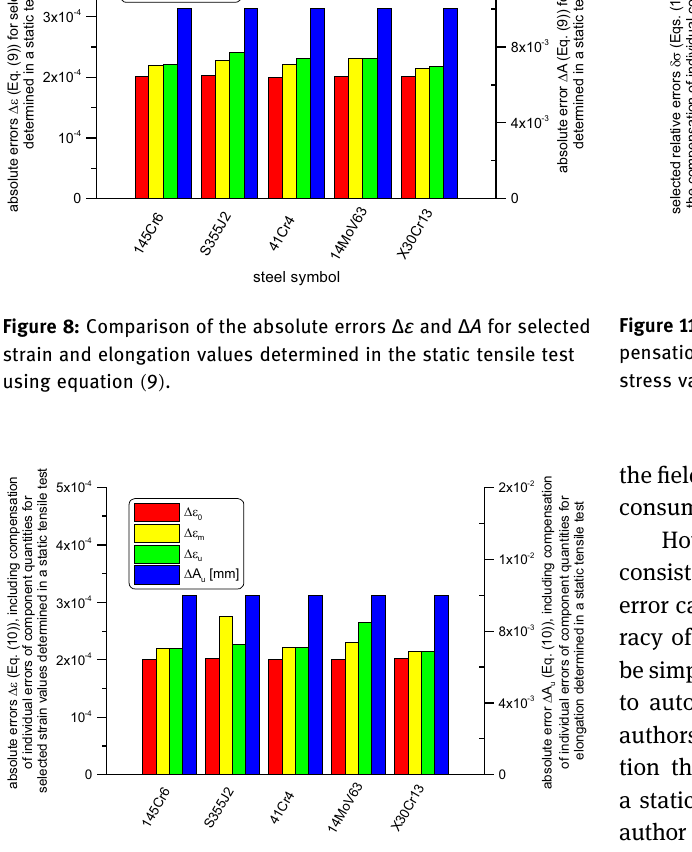
Figure 9: Comparison of the absolute errors Δ ε and Δ A including the compensation for individual errors of component quantities, for selected strain and elongation values using equation ( 10 ) .